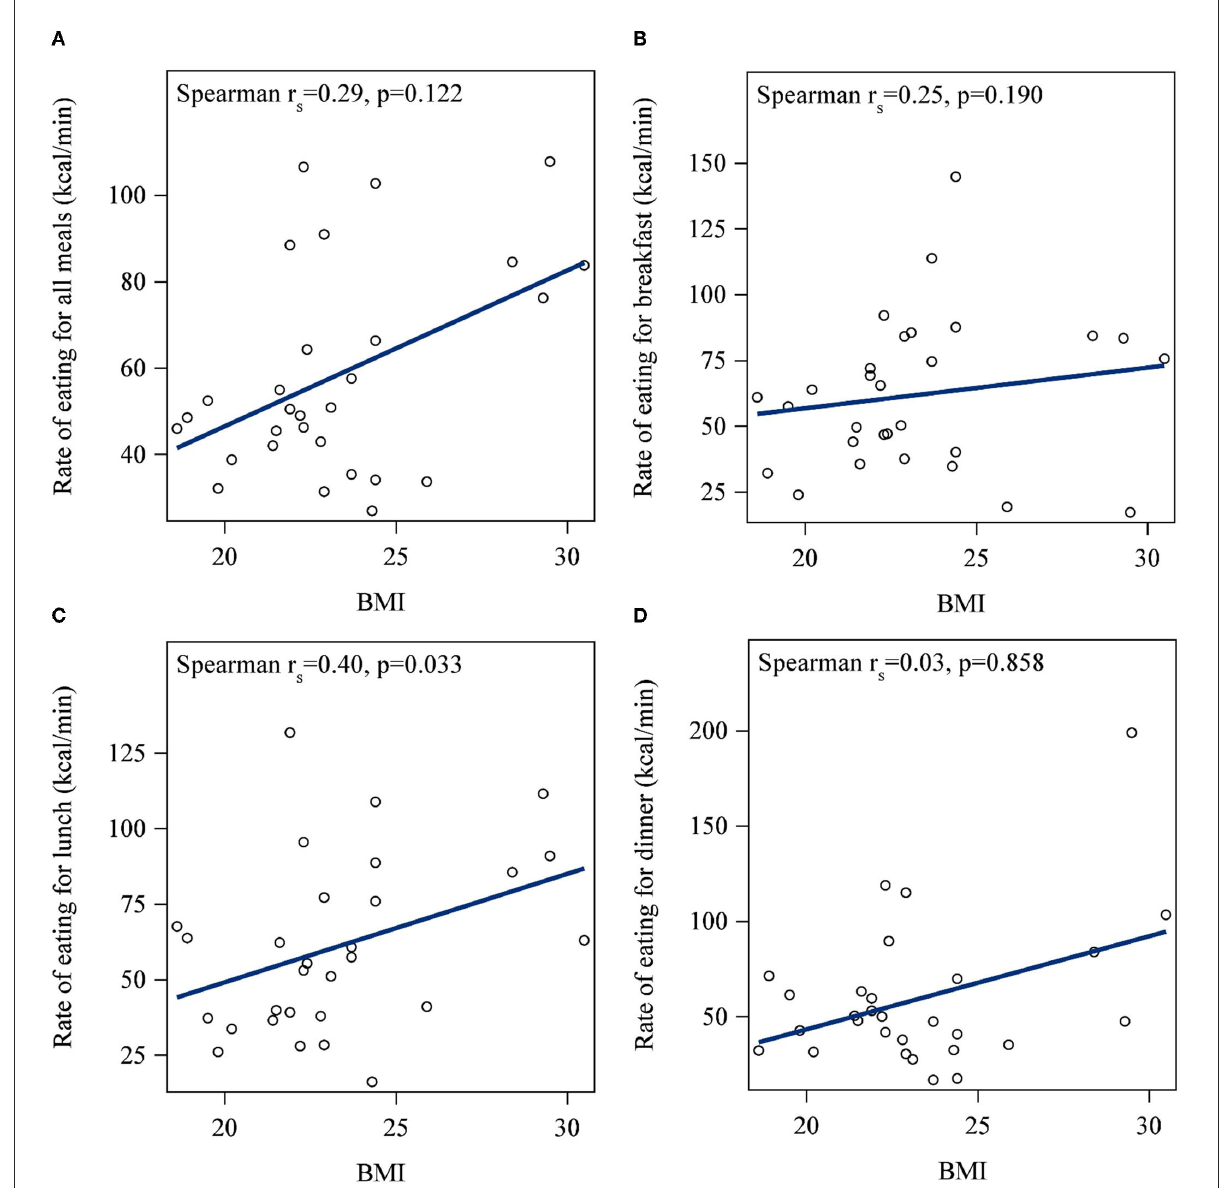
FIGURE1 Correlations between body mass index (BMI) and meal duration for (A) all meals, (B) breakfast, (C) , lunch, and (D) dinner. No significant bivariate correlation was found between BMI and meal duration for all meals or any individual